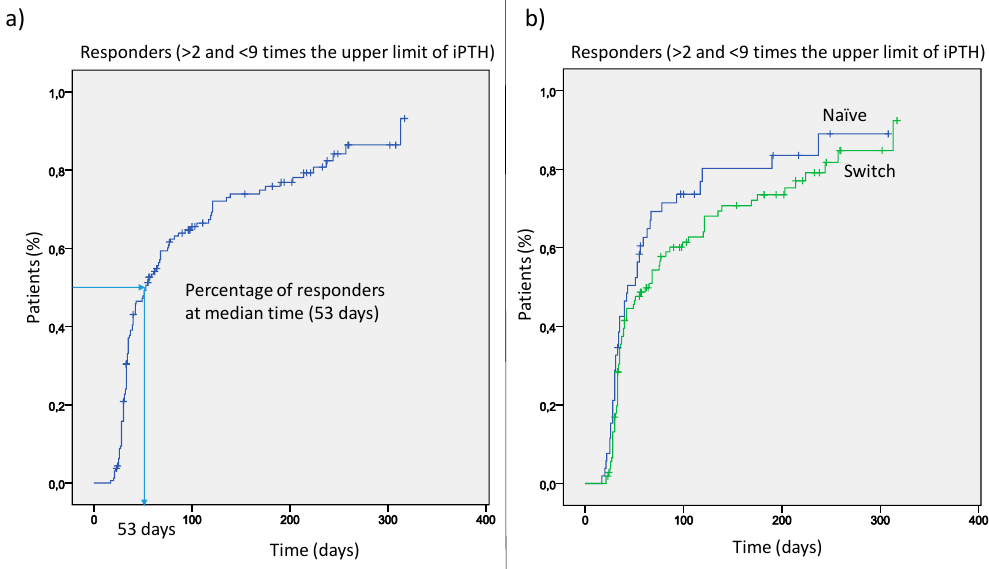
Figure 2. The median time for responders in the whole cohort ( a ) and differentiated for naïve patients and patients switched from cinacalcet to etelcalcetide ( b ).